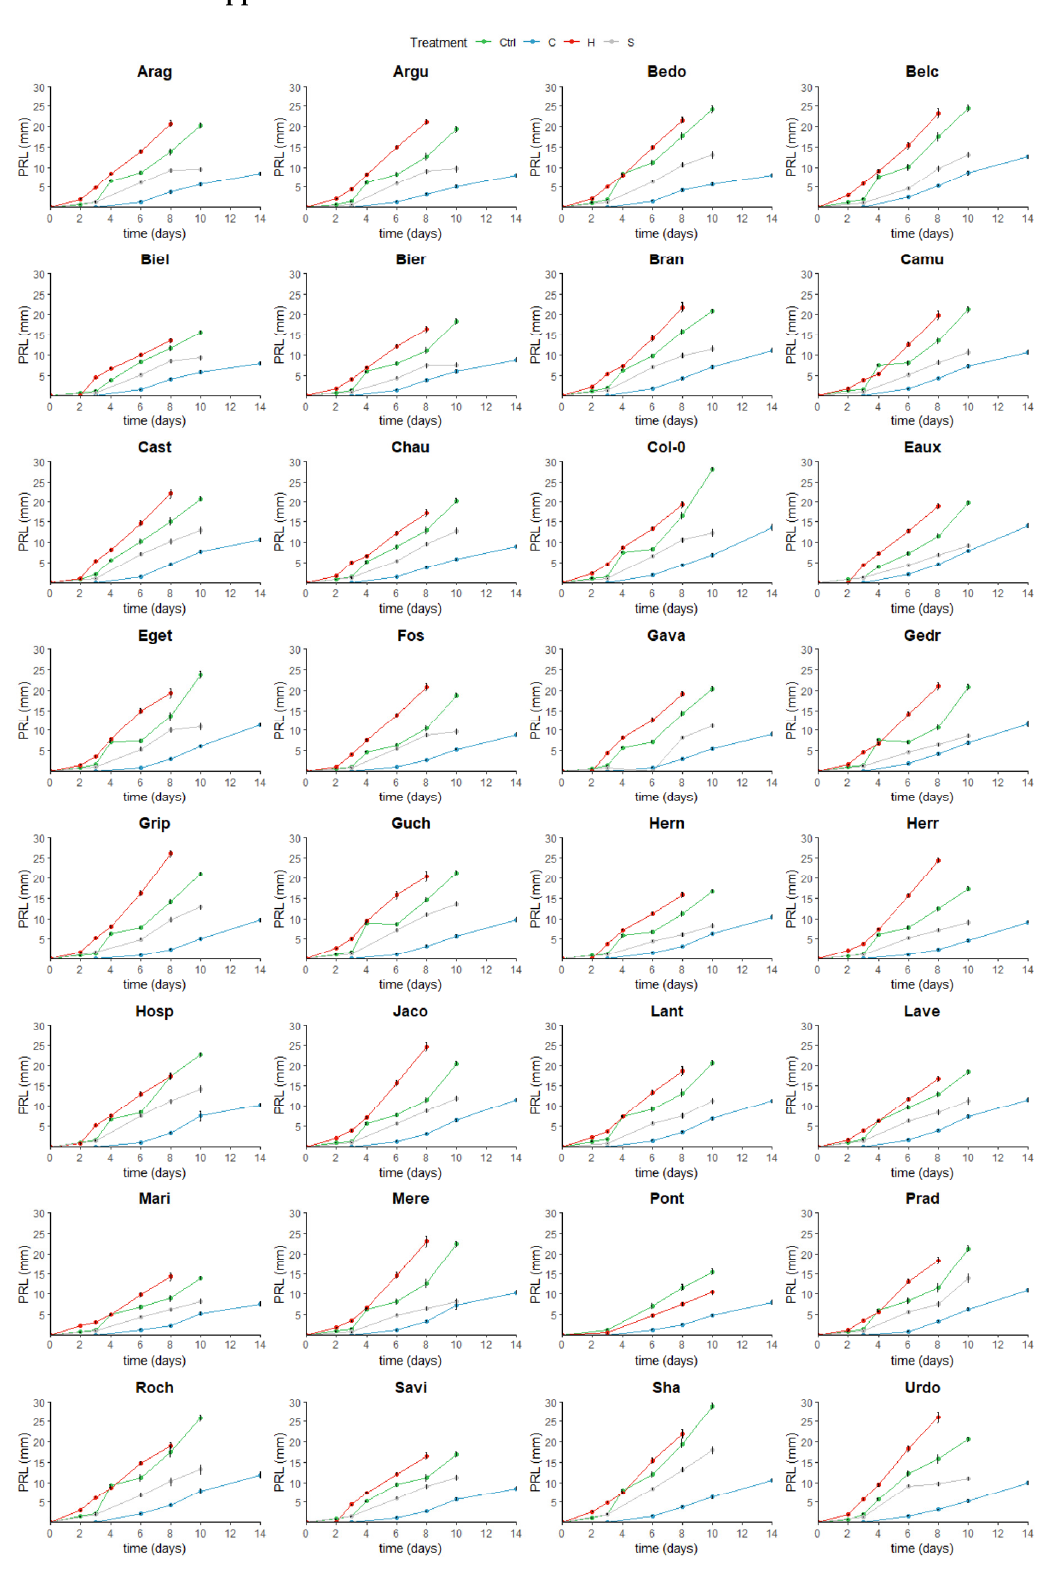
Figure A1. Line graphs displaying the primary root length (PRL in mm) for each population over time (days) under each growth condition (ctrl: green, cold: blue, heat: red, and salt: grey). The error bars present the standard error of